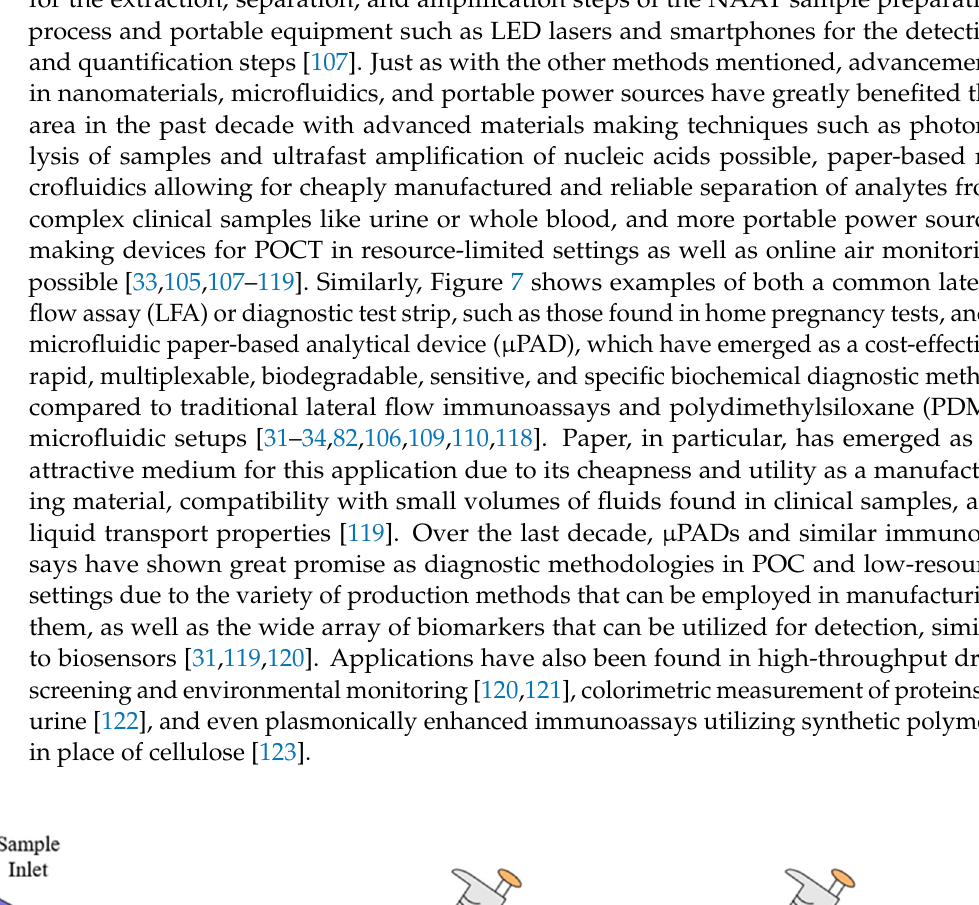
Figure 7. Generalized lateral flow assay (LFA) or dipstick test ( top ) and microfluidic paper-based analytical devices ( μ PADs) used for diagnosis ( bottom ).